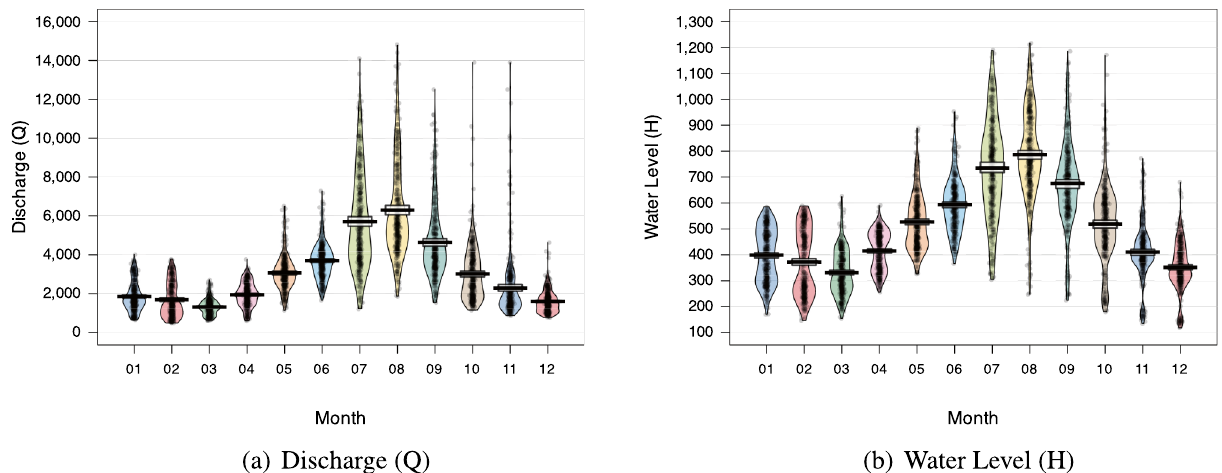
Figure 5. Pirate plot for monthly Discharge and water level of Son Tay dataset. The values during the rainy season (from July to October) are significantly higher than those in the other